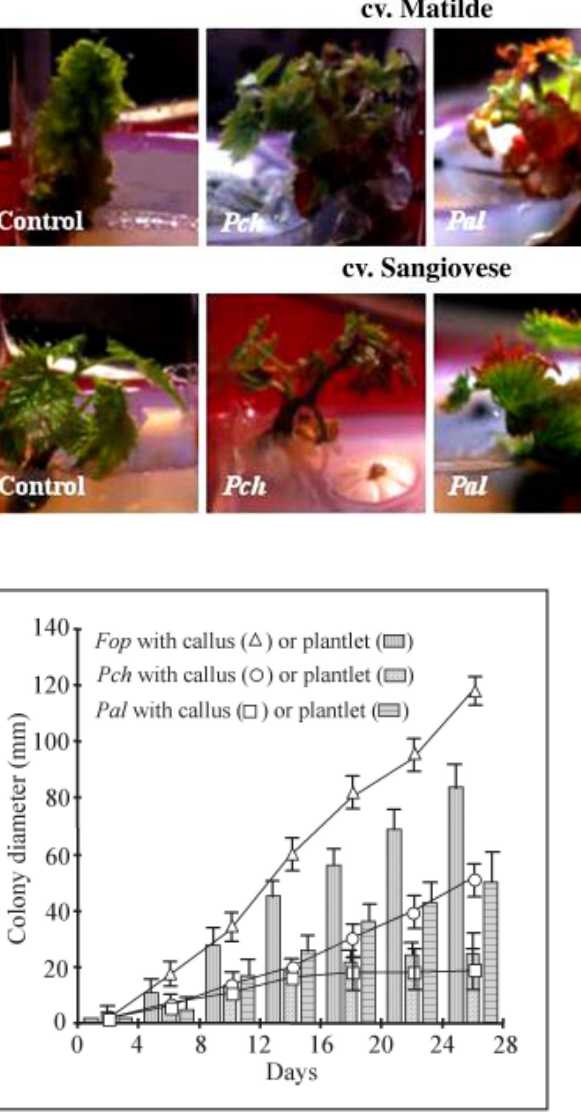
Fig. 5. Plantlets of